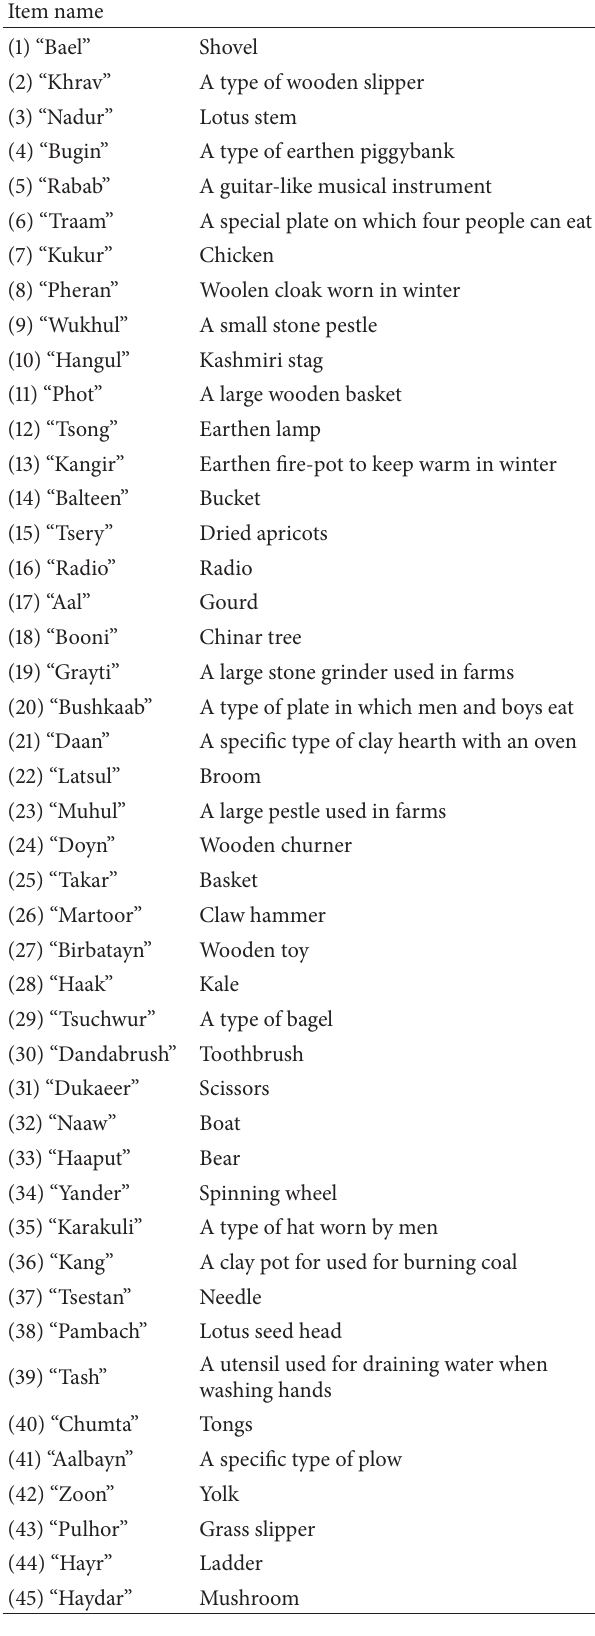
Table 4: Kashmiri Naming